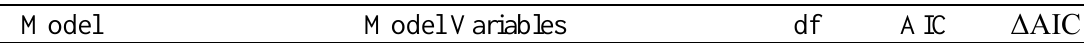
Table A2.4 Akaike information Criteria (AIC), change in AIC (ΔAIC) and degrees of freedom (df) from the top competing regression models of household adaptation success ratio as a function of individual indicators of household